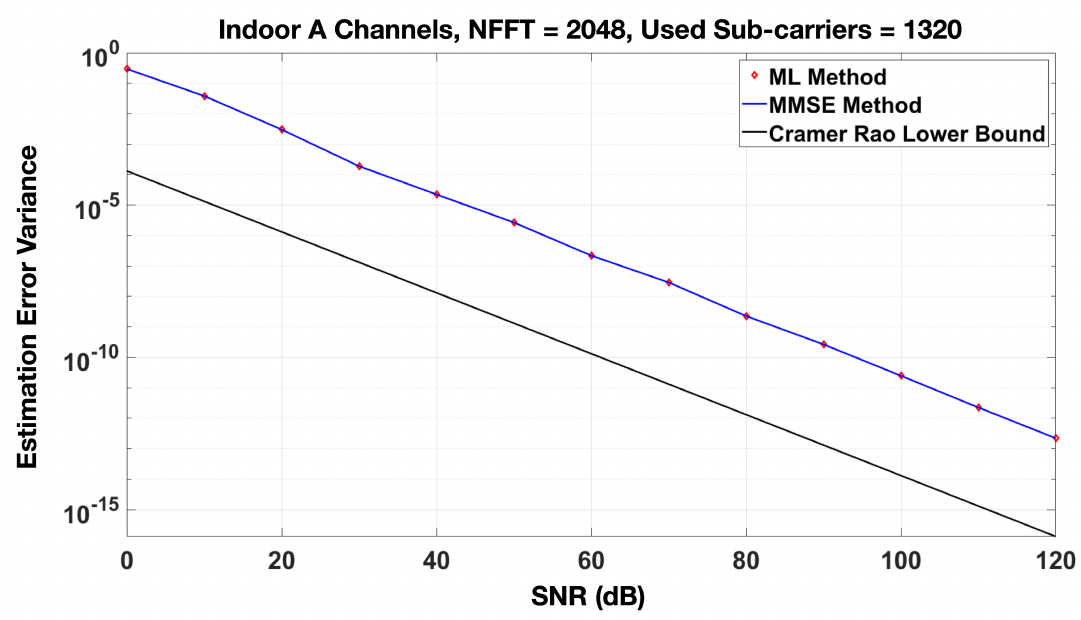
Figure 6. Comparison of channel estimation error variance between Maximum